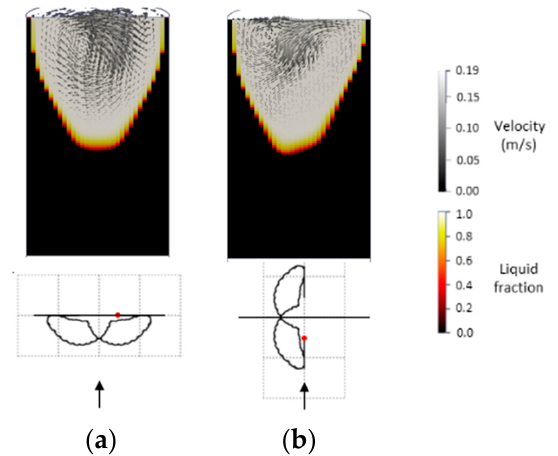
Figure 12. Distributions of the liquid fraction and the velocity of the liquid metal in two perpen- dicular transverse sections ( a ) 𝑦 = 0 and ( b ) 𝑥 = 0 of the ingot at the same time instant considered in Figure 10.